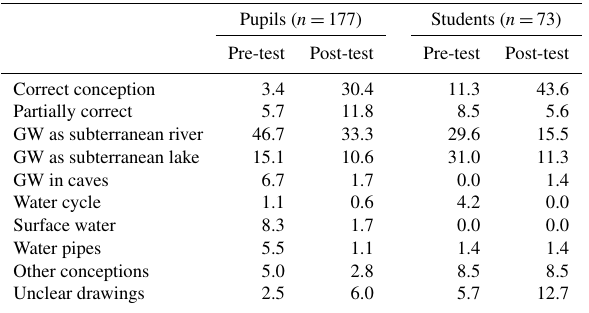
Table 3. Comparison of the conceptions of groundwater of pupils and students from the experimental group in the pre- and post-tests (in